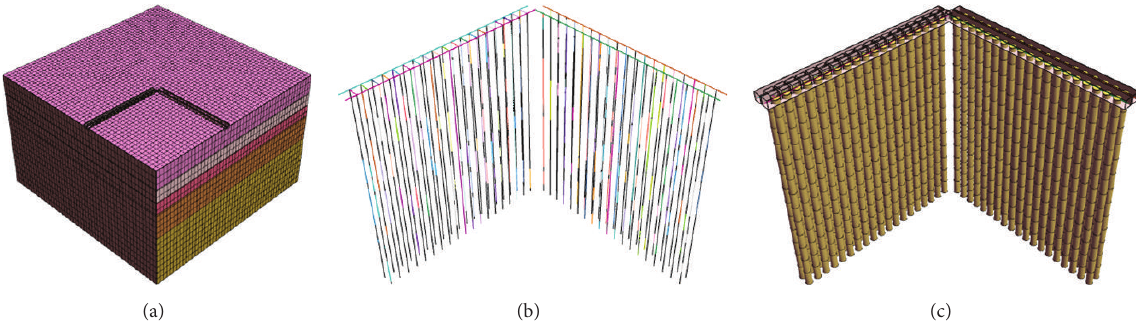
Figure 6: (a) Finite element mesh model; (b) and (c) the piles-beam